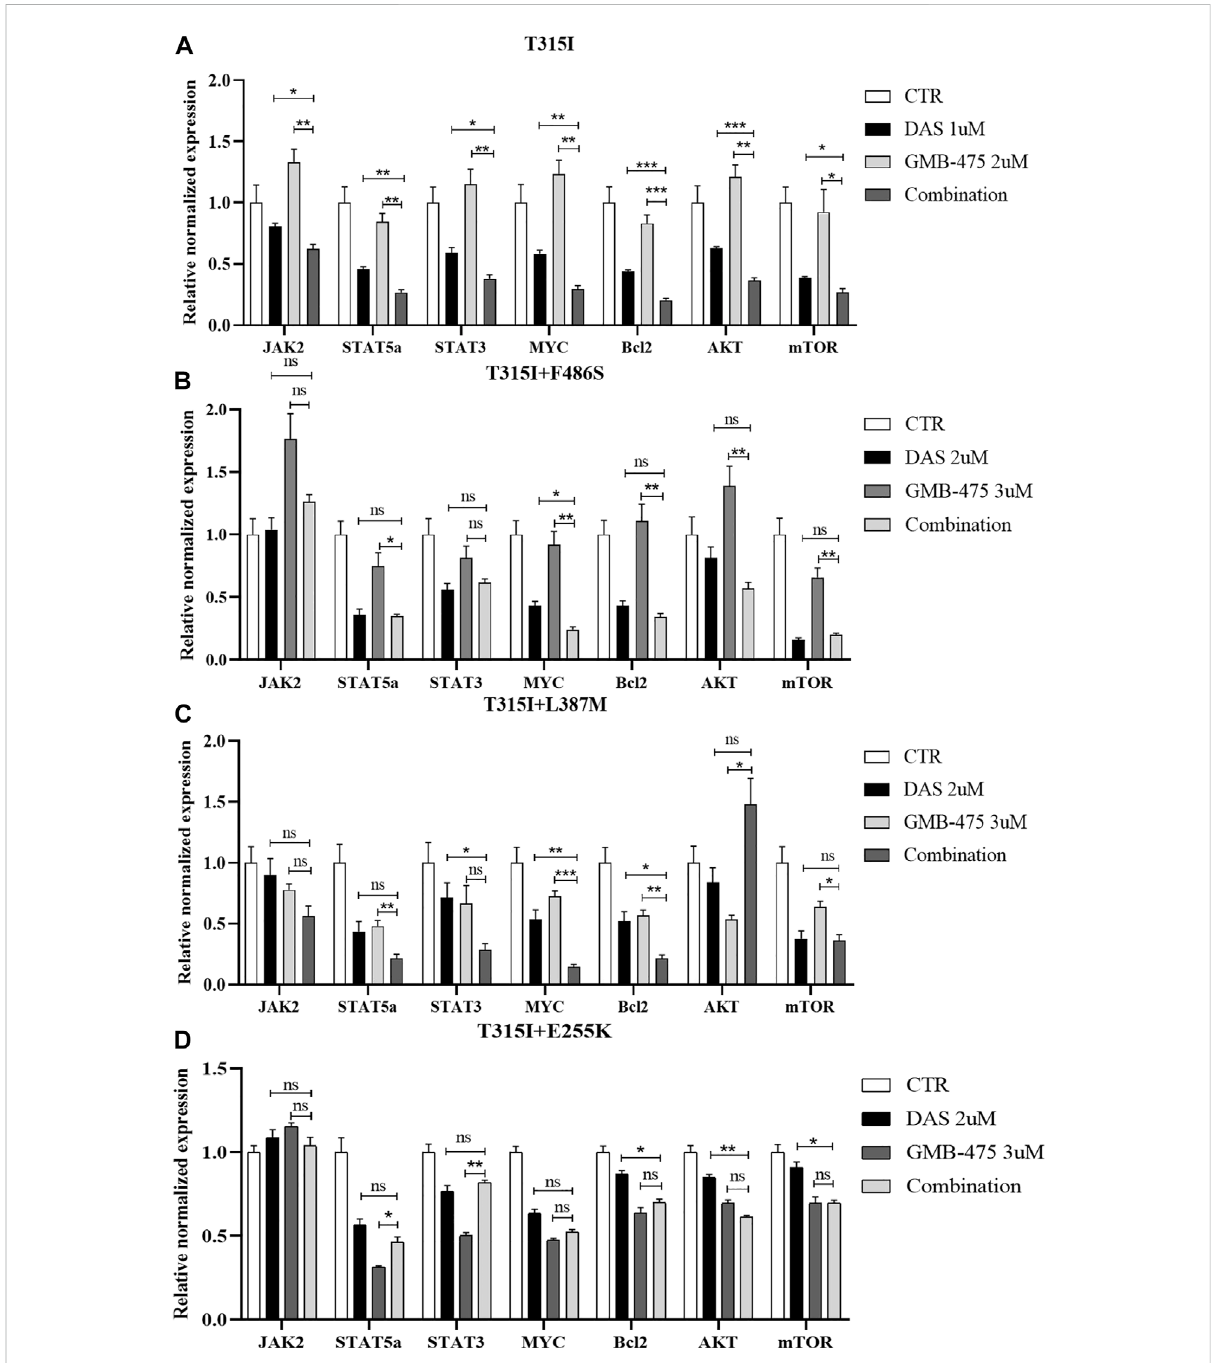
GMB-475 combined with dasatinib synergistically downregulated the mRNA levels of the JAK-STAT axis, AKT , and mTOR in Ba/F3-MIG- p210 cells with BCR::ABL1 mutants. The mRNA levels of genes in Ba/F3-MIG-p210 cells treated with control medium (CTR), GMB-475, dasatinib (DAS), or GMB-475 plus dasatinib for 48 h were detected by qPCR: (A) Ba/F3-MIG-p210 cells carrying BCR::ABL1 T315I mutation were treated with CTR, dasatinib 1 µM, GMB-475 2 µM, and GMB-475 2 µM plus dasatinib 1 µM. (B – D) Ba/F3-MIG-p210 cells carrying BCR::ABL1 T315I+F486S , BCR:: ABL1 T315I+L387M , or BCR::ABL1 T315I+E255K compound mutations were treated with CTR, dasatinib 2µM, GMB-475 3 µM, and GMB-475 3 µM plus dasatinib 2 µM, respectively. The types of BCR::ABL1 mutants carried by Ba/F3-MIG-p210 cells are marked at the top of the fi gures. ns p ≥ 0.05, * p < 0.05, ** p < 0.01, *** p <